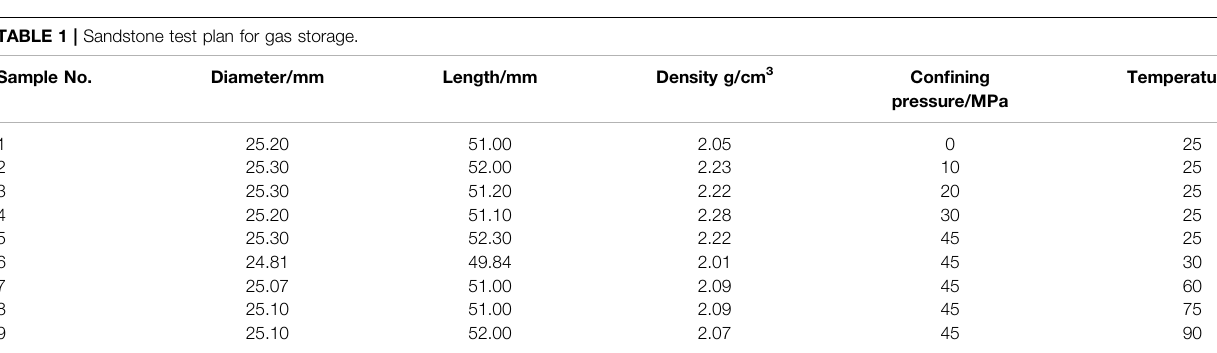
TABLE 1 | Sandstone test plan for gas storage. Sample